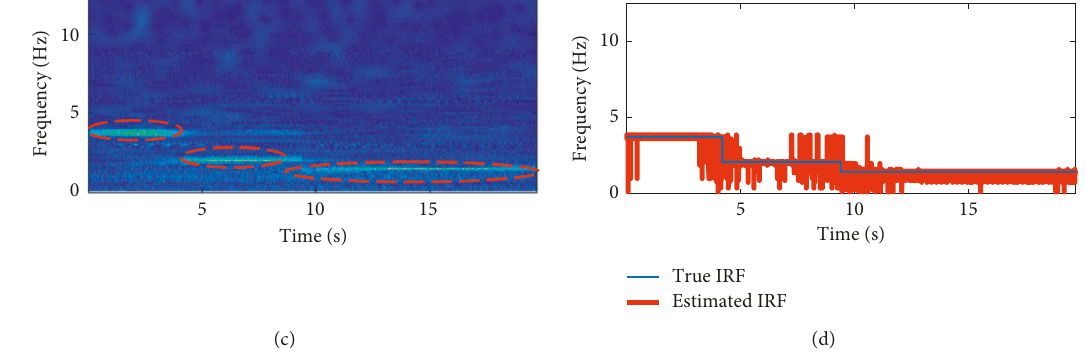
Figure 12: The results of the instantaneous rotational frequency estimation based on continuous wavelet transform: (a) the detailed time- frequency distribution of experiment 1; (b) the instantaneous rotational frequency of experiment 1; (c) the detailed time-frequency distribution of experiment 2; (d) the instantaneous rotational frequency of experiment 2.